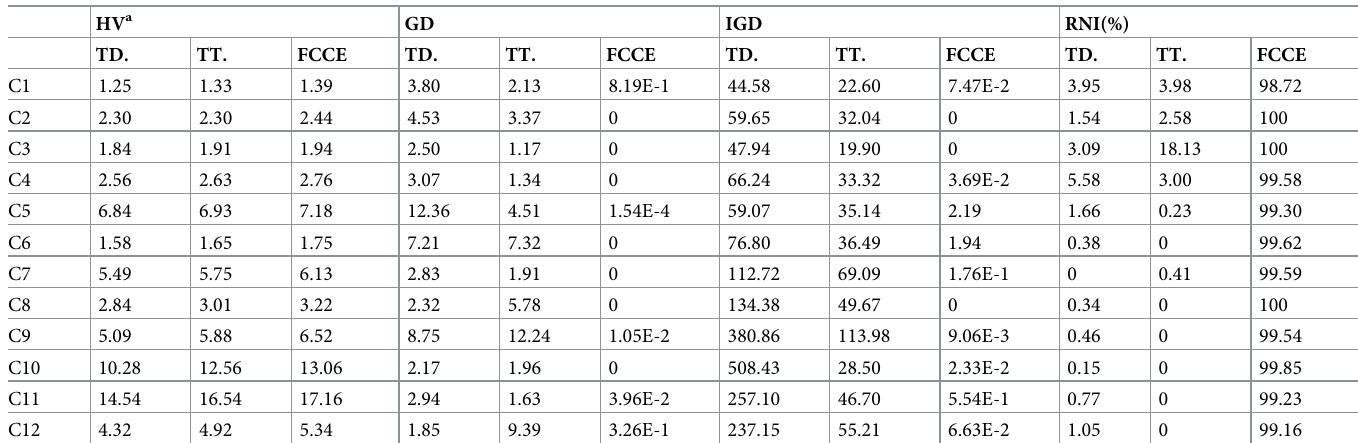
Table 5. Performance indicators of three